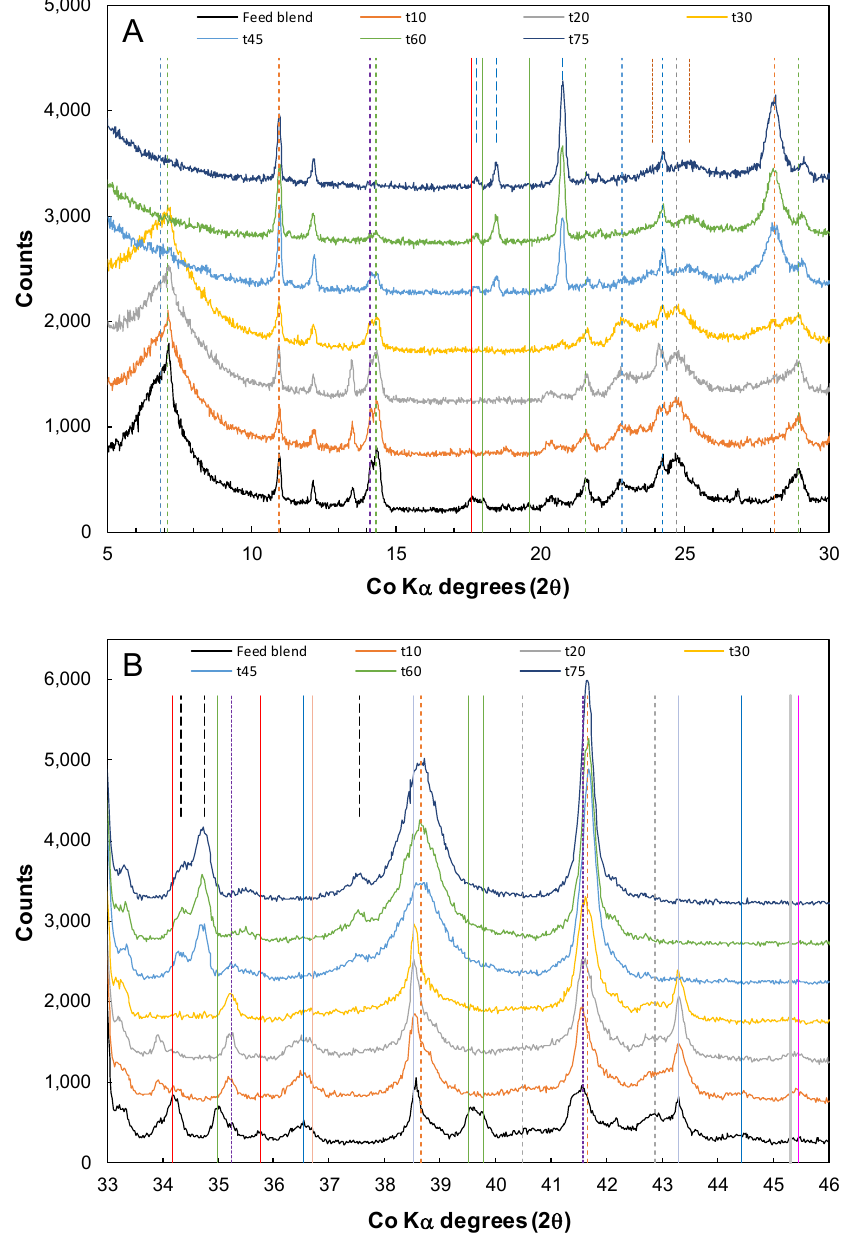
Figure 6. XRD patterns for selected angle ranges of the feed blend after heating to temperature (t0) and samples (t10, t20, t30, t45, t60, and t90) taken during the co-processing of 19.5% w / w nickel laterite ore with 10.5% w / w nickel concentrate in site water at 250 ◦ C. Selected peaks positions ( ◦ 2 θ ) are shown for the following minerals: nontronite (6.85, 22.82), clinochlore (7.12, 14.33, 21.57, 28.94), talc (10.95), lizardite (14.12), quartz (24.22), goethite (24.70, 38.67, 40.49, 42.86), pyrrhotite 4C (18.01, 19.64, 34.98, 39.51, 39.78), pyrite (38.52, 43.29), marcasite (45.45), pentlandite (17.63, 24.18, 34.18, 35.75), violarite (36.54, 44.43), vaesite (36.70, 45.30), hematite (28.10, 38.60, 41.65), Na-alunite (17.80, 18.49, 20.80, 34.33, 34.75, 37.55). ( A ) angle range 5–30 ◦ 2 θ ; ( B ) angle range 33–46 ◦ 2 θ .